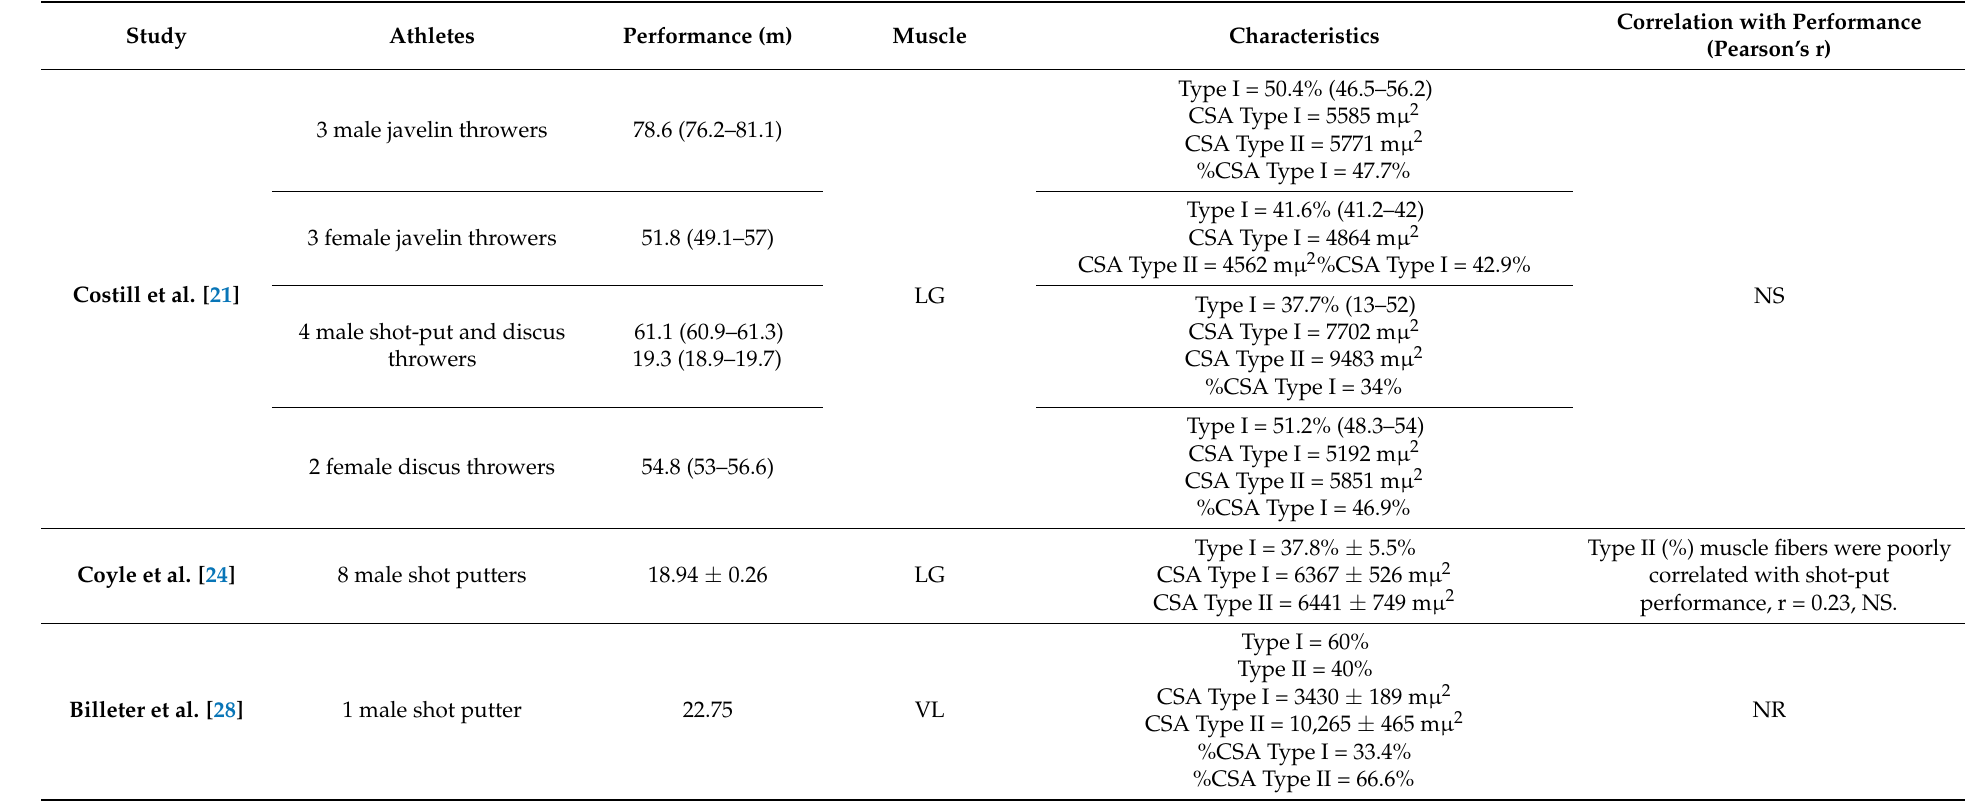
Table 3. Description of muscle fiber type characteristics in throwers and correlations between muscle fiber type composition, cross-sectional area and percentage cross-sectional area with track and field throwing